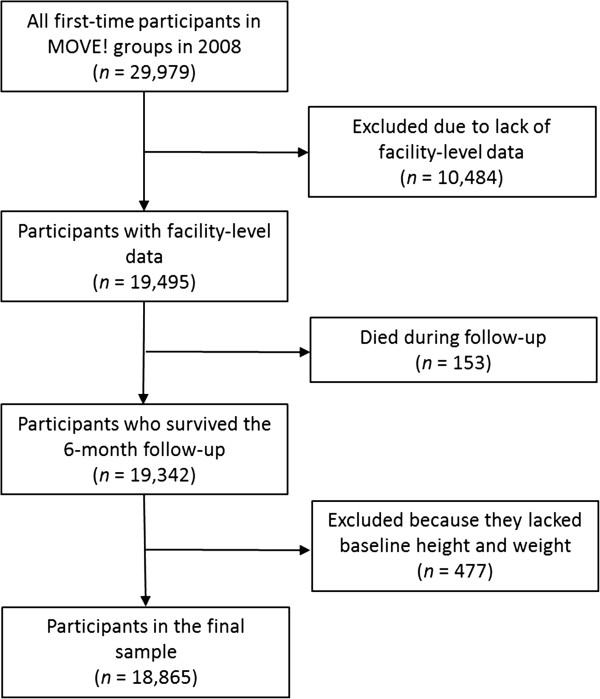
Study flow diagram.